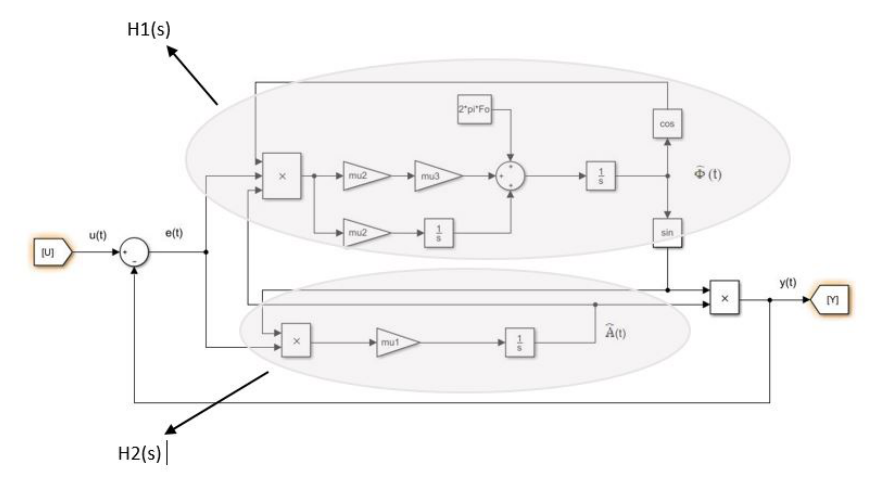
Figure 2. Linearization of the